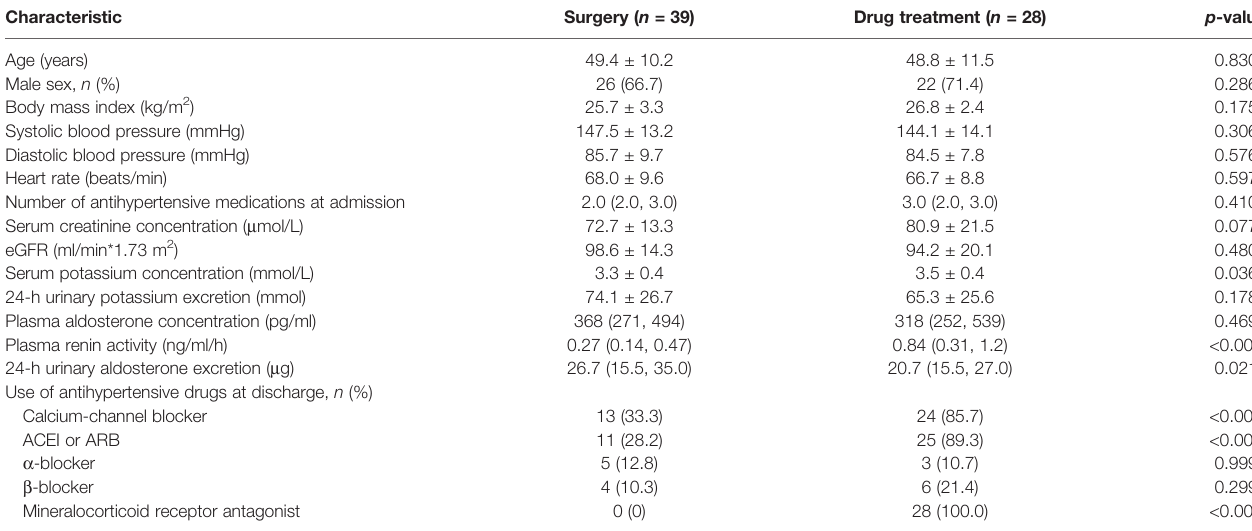
TABLE 1 | Demographic and clinical characteristics at baseline. Characteristic Surgery ( n =